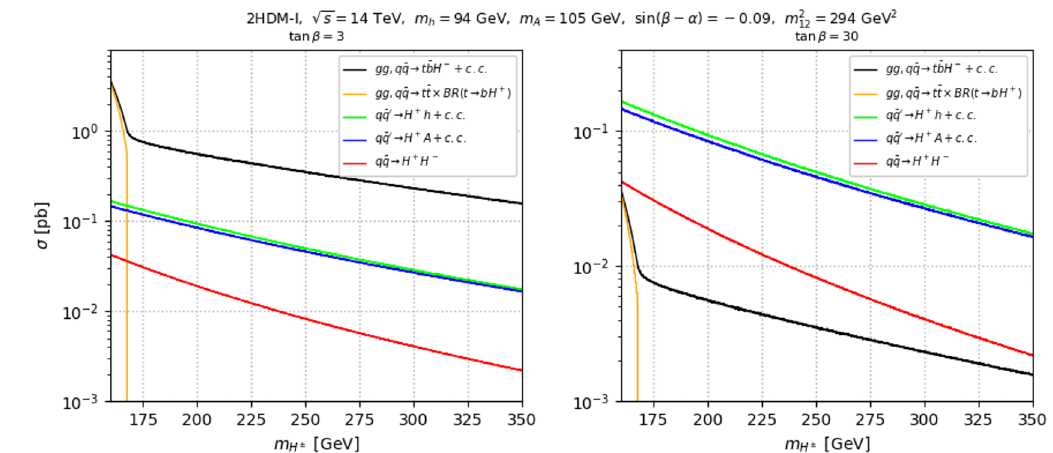
¯ Figure 1 . Cross section for gg, q ¯ q → t bH − + c.c. (black), gg, q ¯ q → t ¯ t × BR( t → bH + ) + c.c. √ (orange), q ¯ q → H + H − (red) and q ¯ q 0 → H ± h/A (green/blue) at s = 14 TeV, as a function of m H ± for tan β = 3 (left) and 30 (right). All cross sections are calculated using the code MadGraph [66] at LO. Note that we have used the MSTW2008 PDF set from [67] with factorisation/renormalisation √ scale set to ˆ s , i.e., the centre-of-mass energy at parton level. and × BR( t → bH + ) + c.c., which are clearly only appearing for m ≤ m − m t b H ±